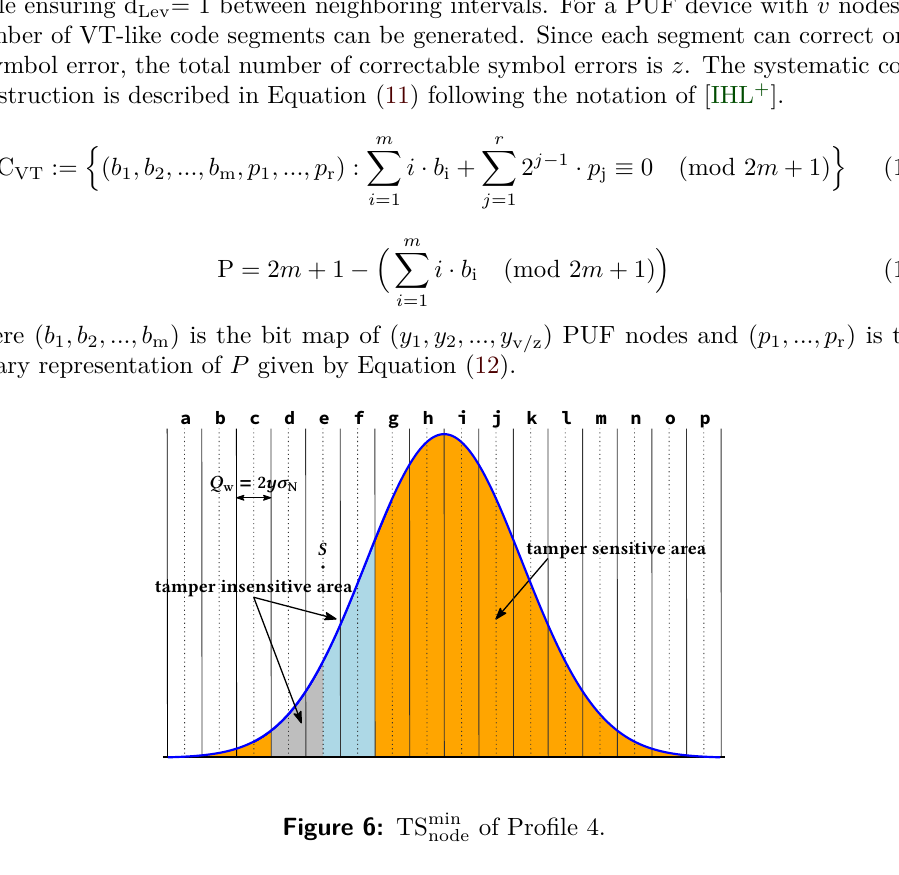
Figure 6: TS min